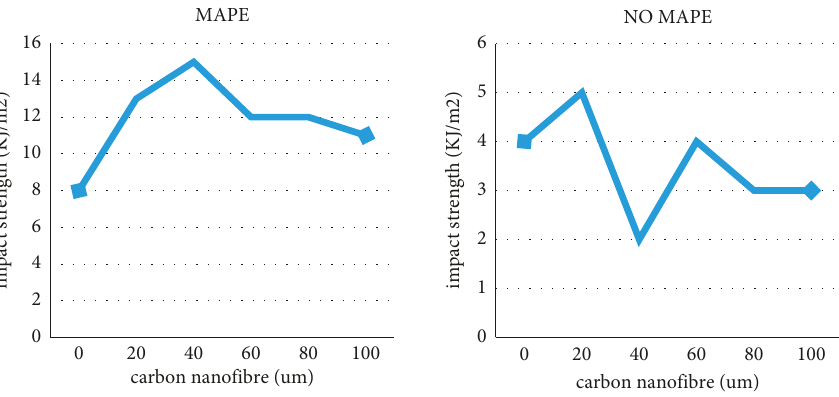
Figure 9: Comparison of impact strength properties of